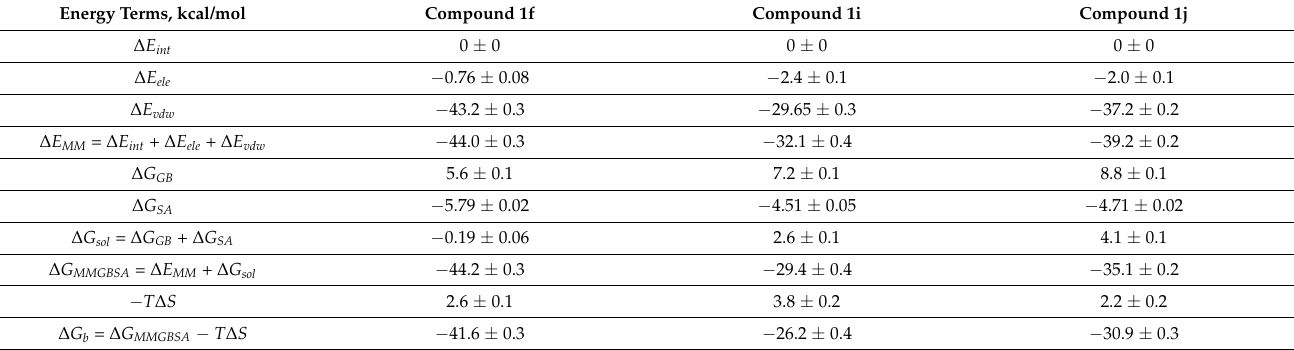
Table 3. Binding free energy for compounds 1f , 1i , 1j , calculated using MM/GBSA